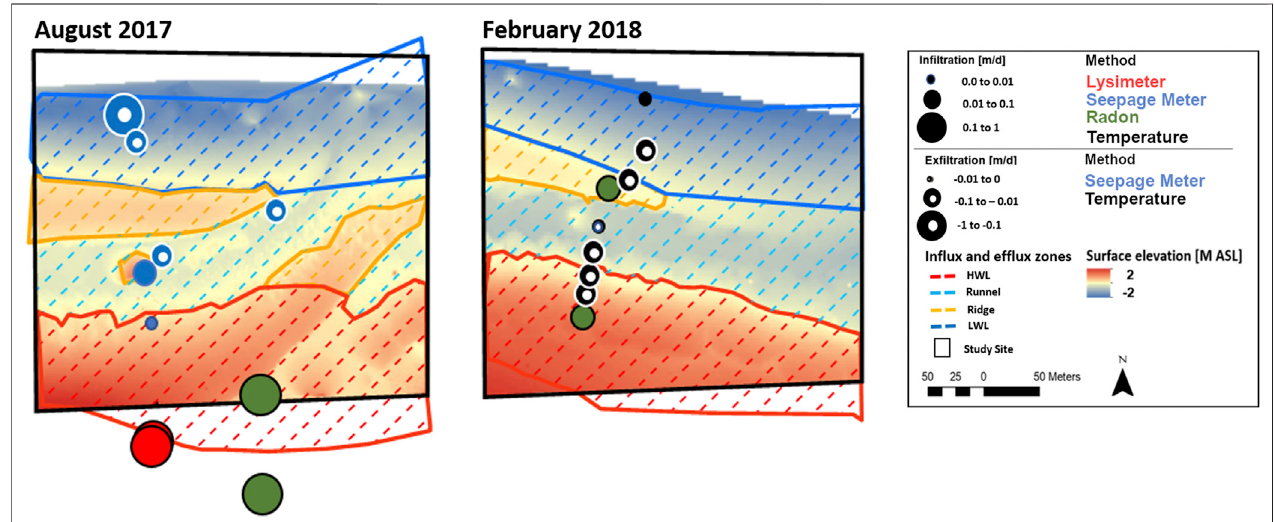
FIGURE5| Determinationofbeachtopography( ∼ 200 m × ∼ 200 m,blackbox)forAugust2017andFebruary2018includingbothlocationandextentofmeasured exchangerates.In fi ltrationratesbasedonlysimetersmeasurements(redcircles)weredisplayedasmeanvaluefromallmeasurementsforrespectivesamplingcampaign at same location. Dashed polygons indicate topography-based classi fi cation of in- and ex fi ltration zones (HWL, Runnel, Ridge, LWL) for the study site based on results from Figure 3 suggesting net in fi ltration above MSL and net ex fi ltration below MSL. Zones for HWL and LWL were linearly extended or reduced beyond the boundariesofthestudysite(blackbox)tocovertheentireareabetweenmeanhighwater(+1.37 mASL)andmeanlowwater( − 1.37 mASL).In fi ltrationratesoutsidethe black box were partially measured due to a shift in HWL during sampling.